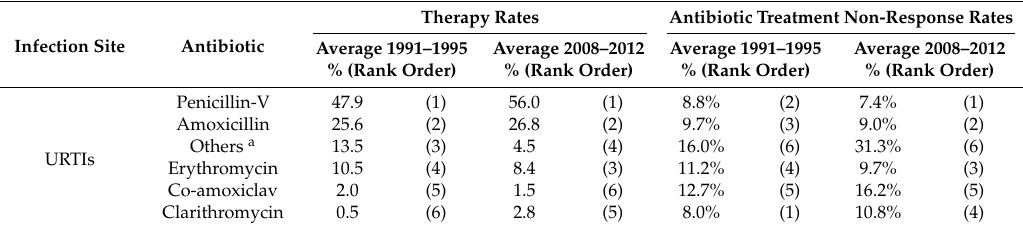
Table 2. Average antibiotic therapy and treatment non-response rates (%) by infection class and by early and late time period with rank order in parentheses.